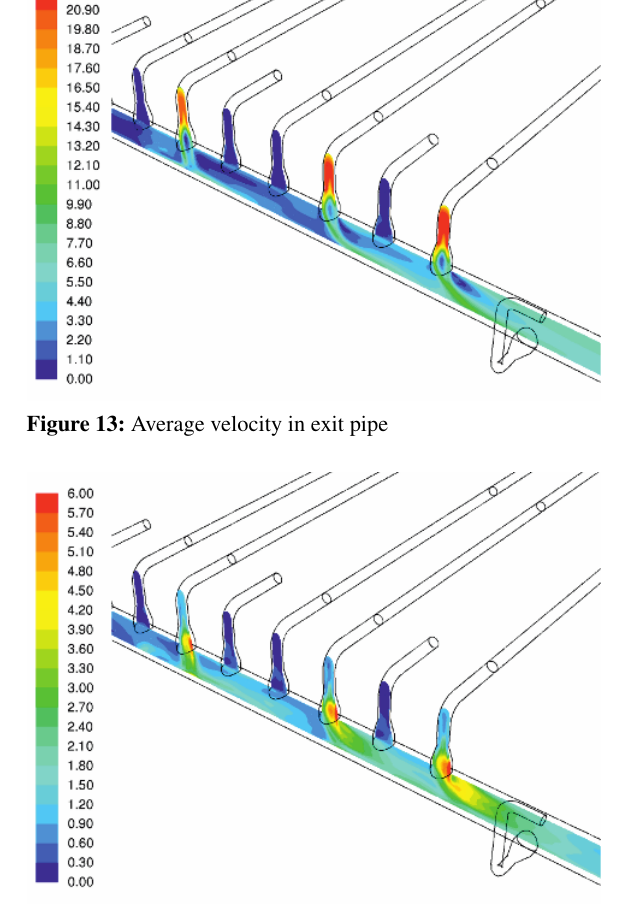
Figure 14: Deviation of velocity in exit pipe